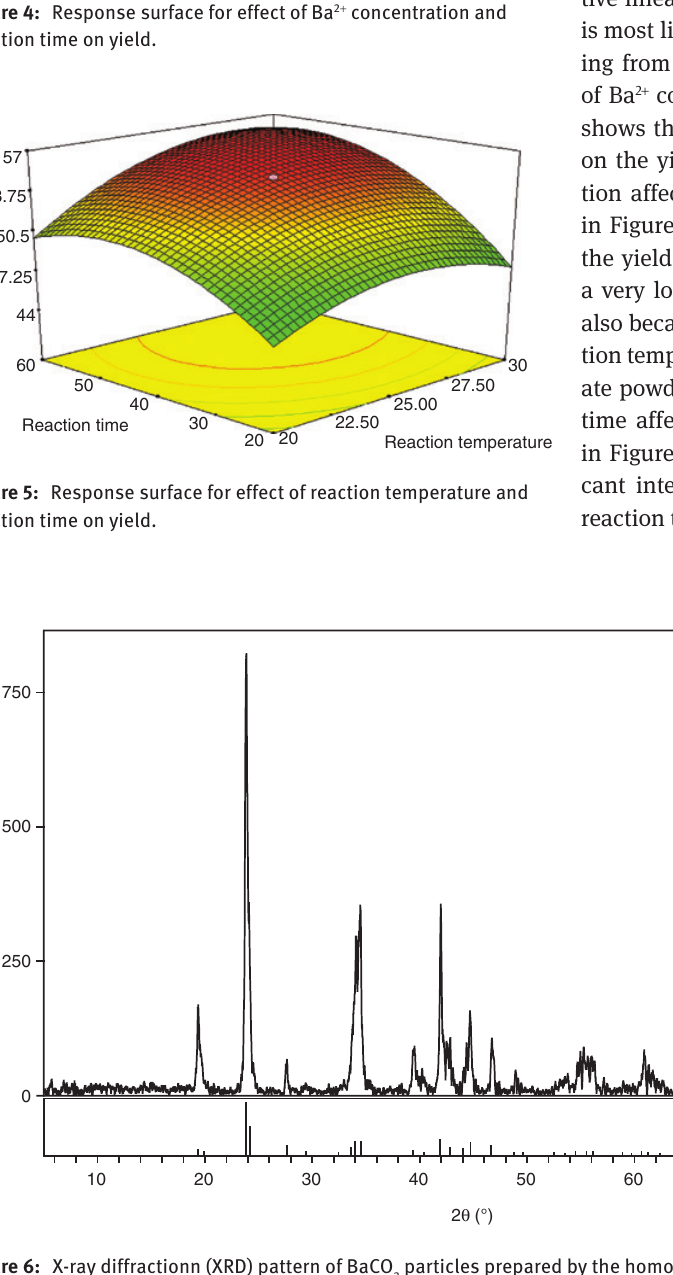
Figure 6: X-ray diffractionn (XRD) pattern of BaCO